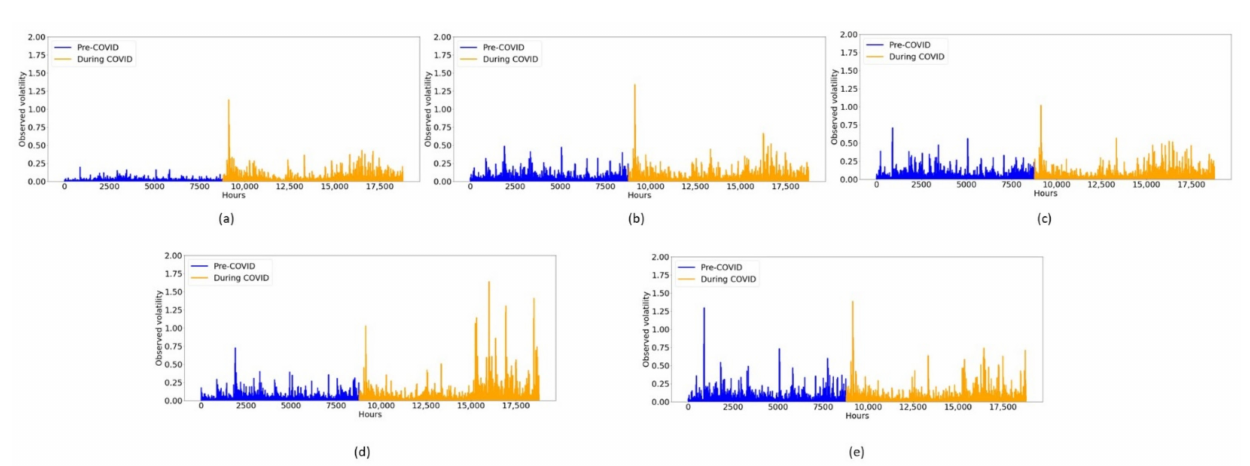
Figure 2. Observed volatility plots for the pre-COVID-19 and COVID-19 periods for ( a ) Bitcoin, ( b ) Ethereum, ( c ) Litecoin, ( d ) Ripple and ( e ) Bitcoin